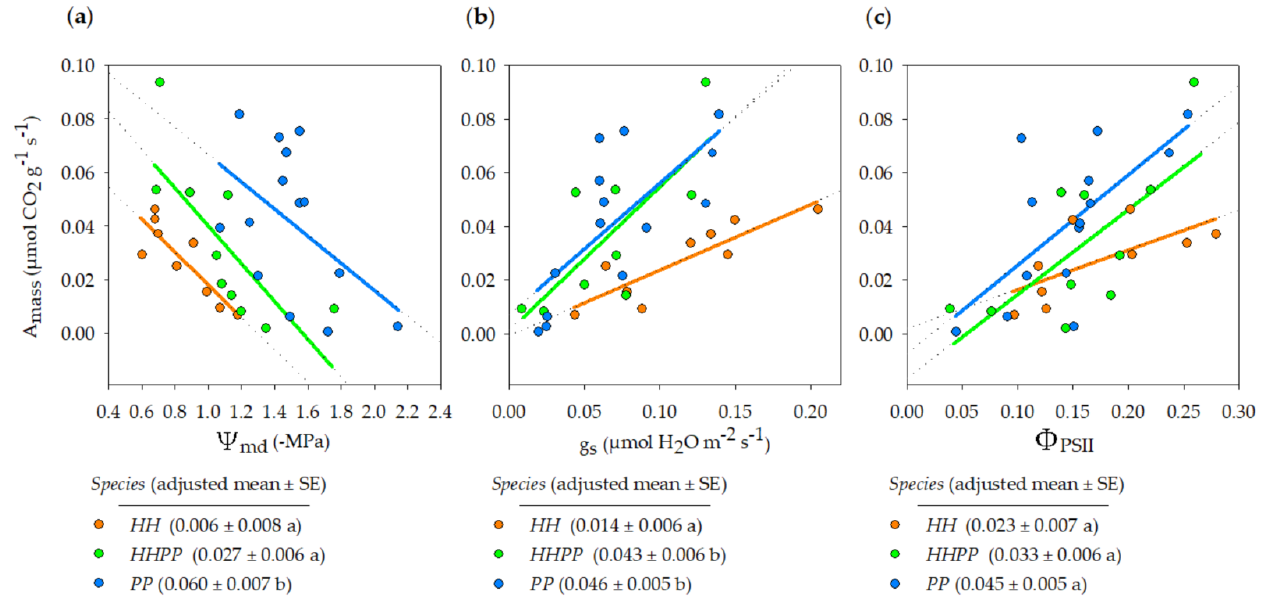
Figure 2. Variation of A mass among the three Oesporangium species while controlling for three covariates: ( a ) Ψ md ; ( b ) g s ; ( c ) Φ PSII . In the tables below each figure, different letters indicate significantly different means ( p < 0.05, Bonferroni tests). n = 9 − 14 individuals per species. See Table 1 for ANCOVA results.